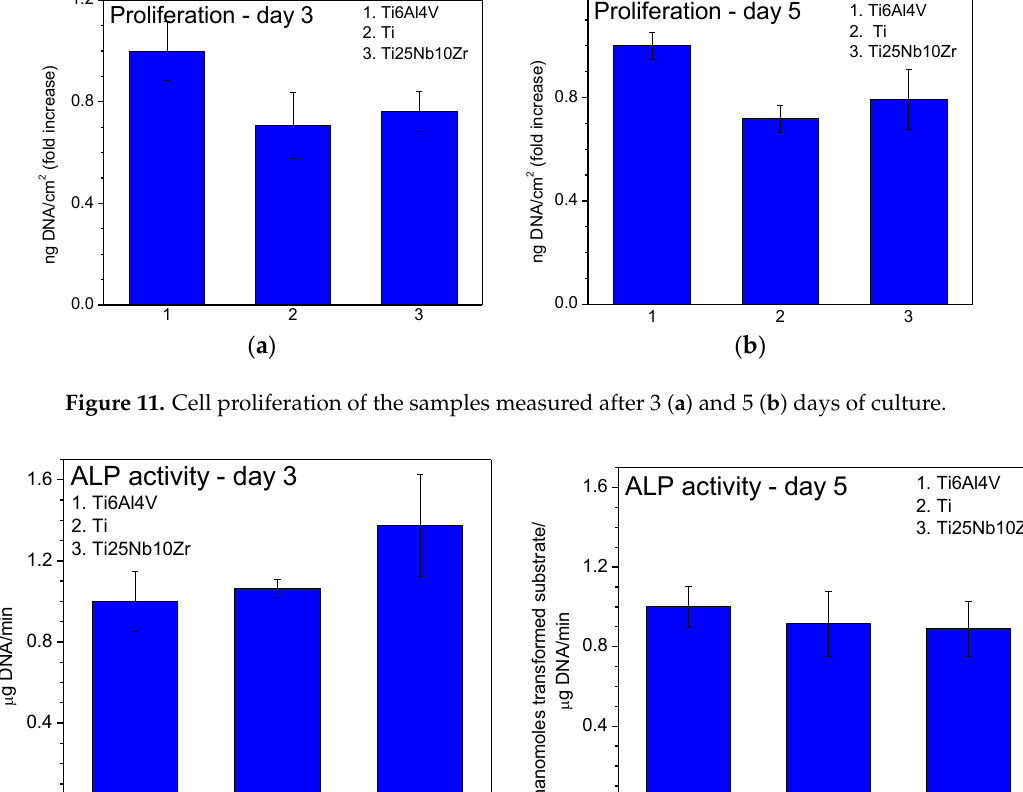
Figure 10. Cellular morphology of osteoblasts grown for 3 days on pure Ti and Ti alloys: ( a )—Immunofluorescence labelling of actin (green) and nucleus (blue) of osteoblast cells cultured for 3 days on the: 1—Ti6Al4V, 2—pure Ti, 3—Ti25Nb10Zr; ( b )—Scanning electron micrograph of osteoblasts after 3 days culture on the: 1—Ti6Al4V, 2—pure Ti, 3—Ti25Nb10Zr.